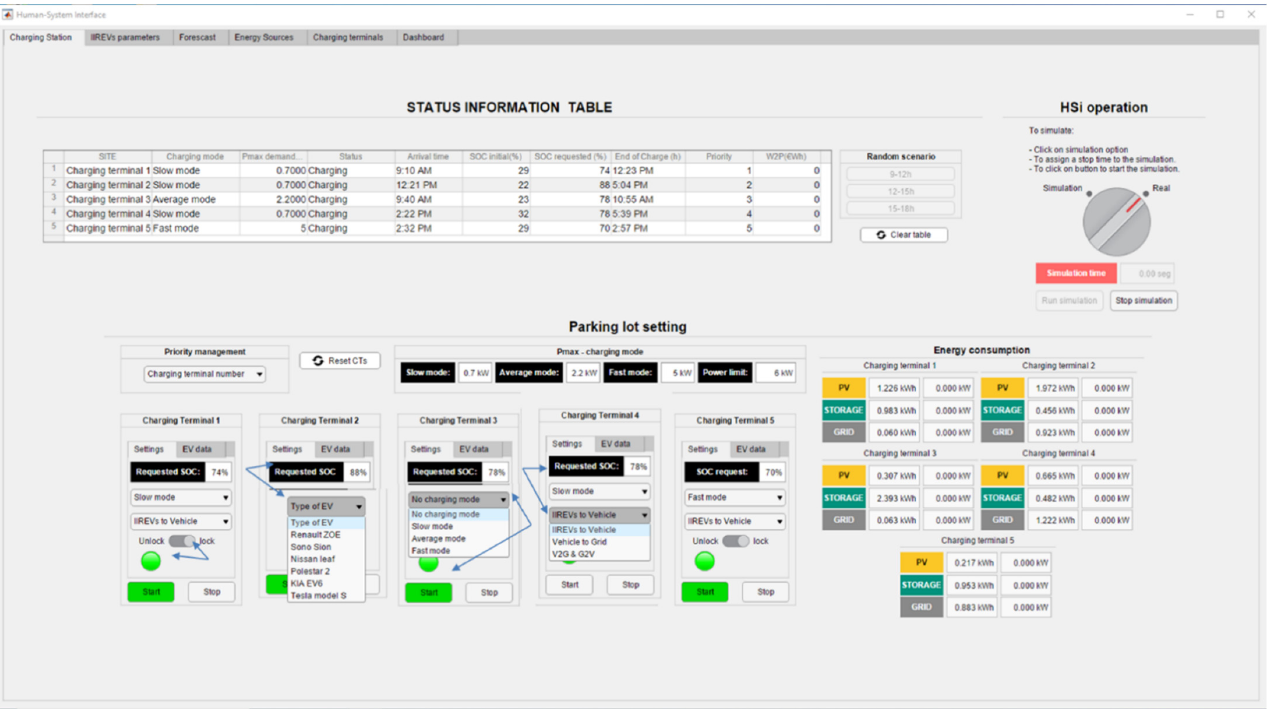
Figure 3. Human-machine interface for the IIREVs.